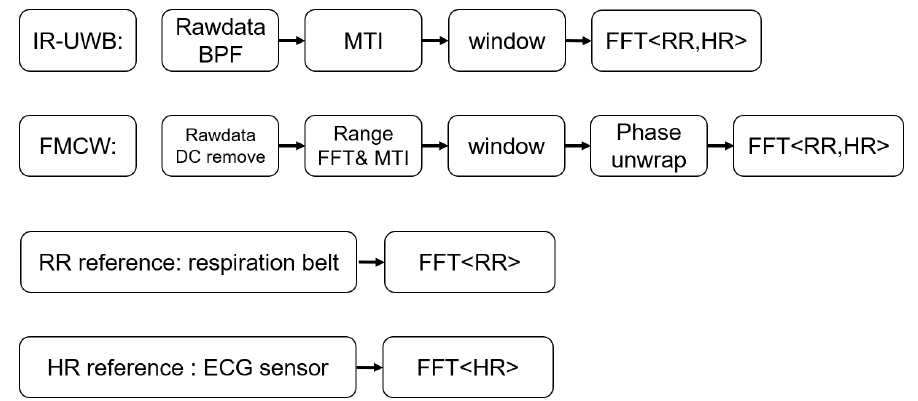
Figure 1. Block diagram of the algorithm used in